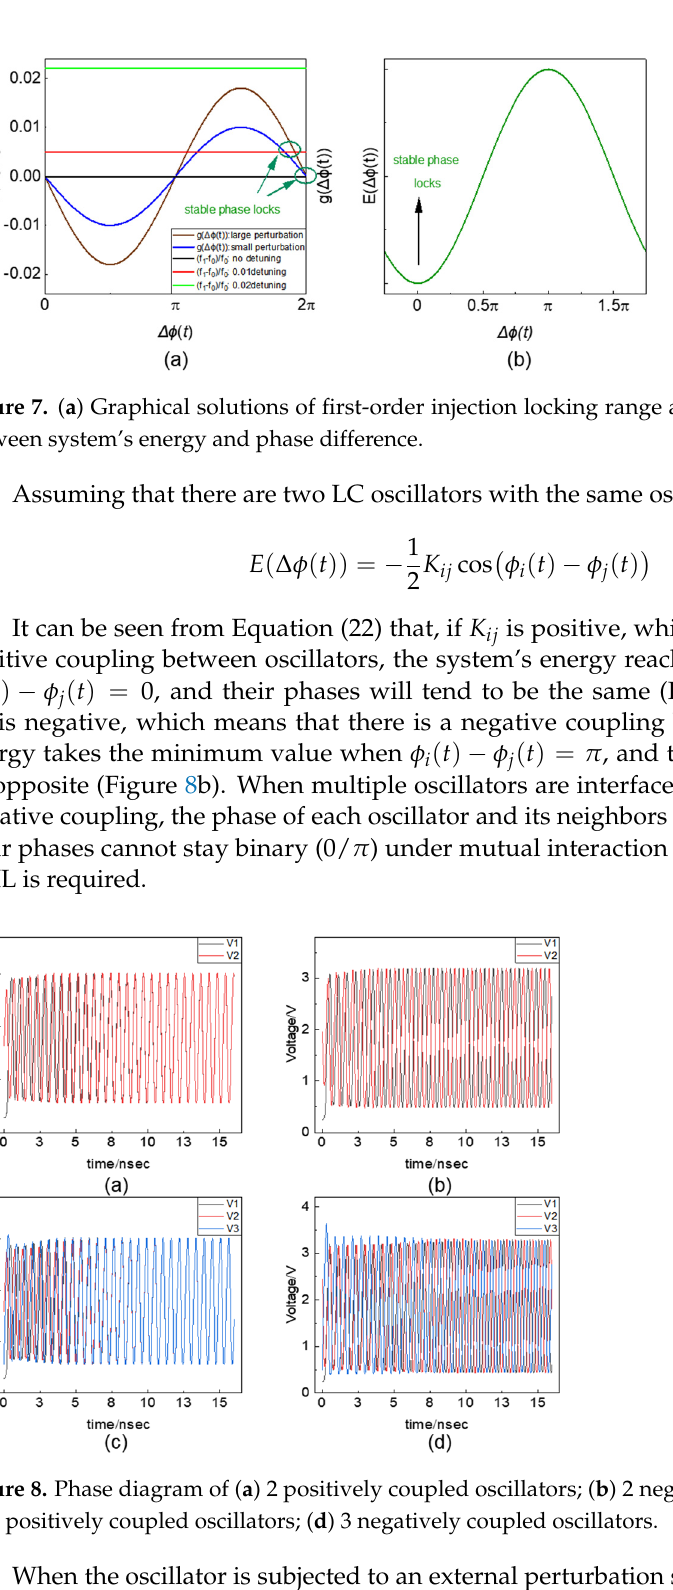
system energy in Figure 7b. However, which point represents the steady (or unsteady) state